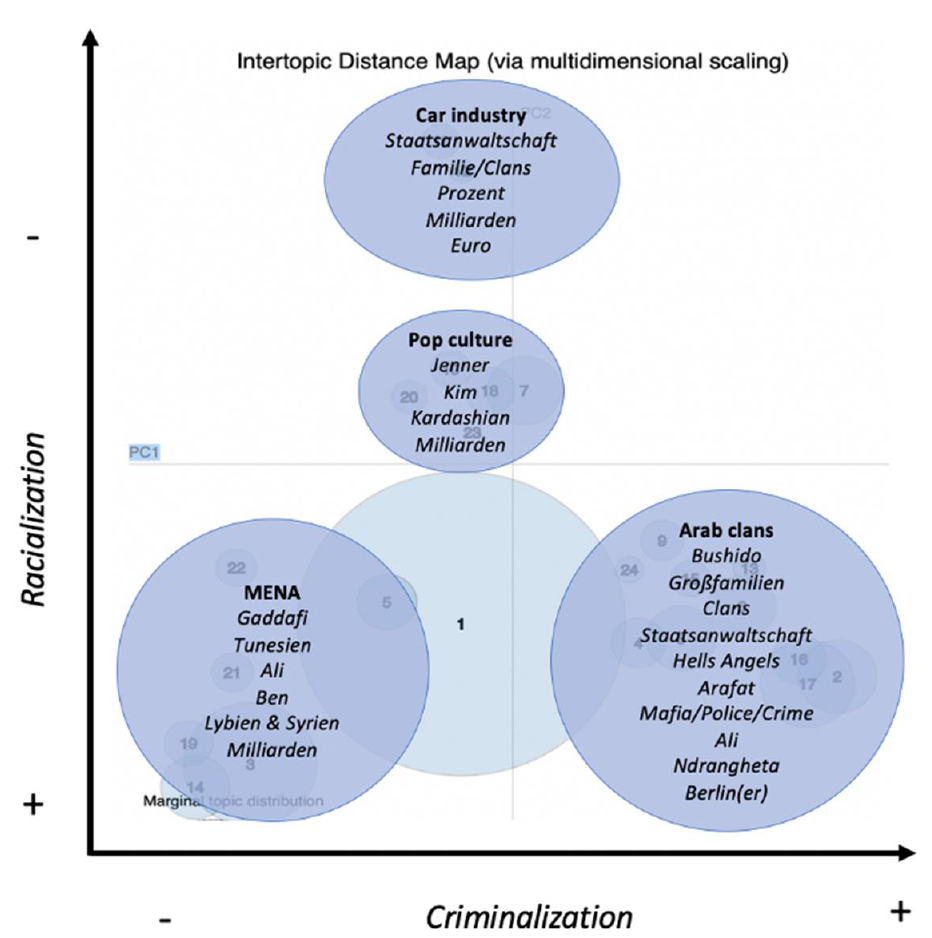
Figure 1. Intertopic distance map of the German media discourse about ‘clans’ (2010–2019) 3 .